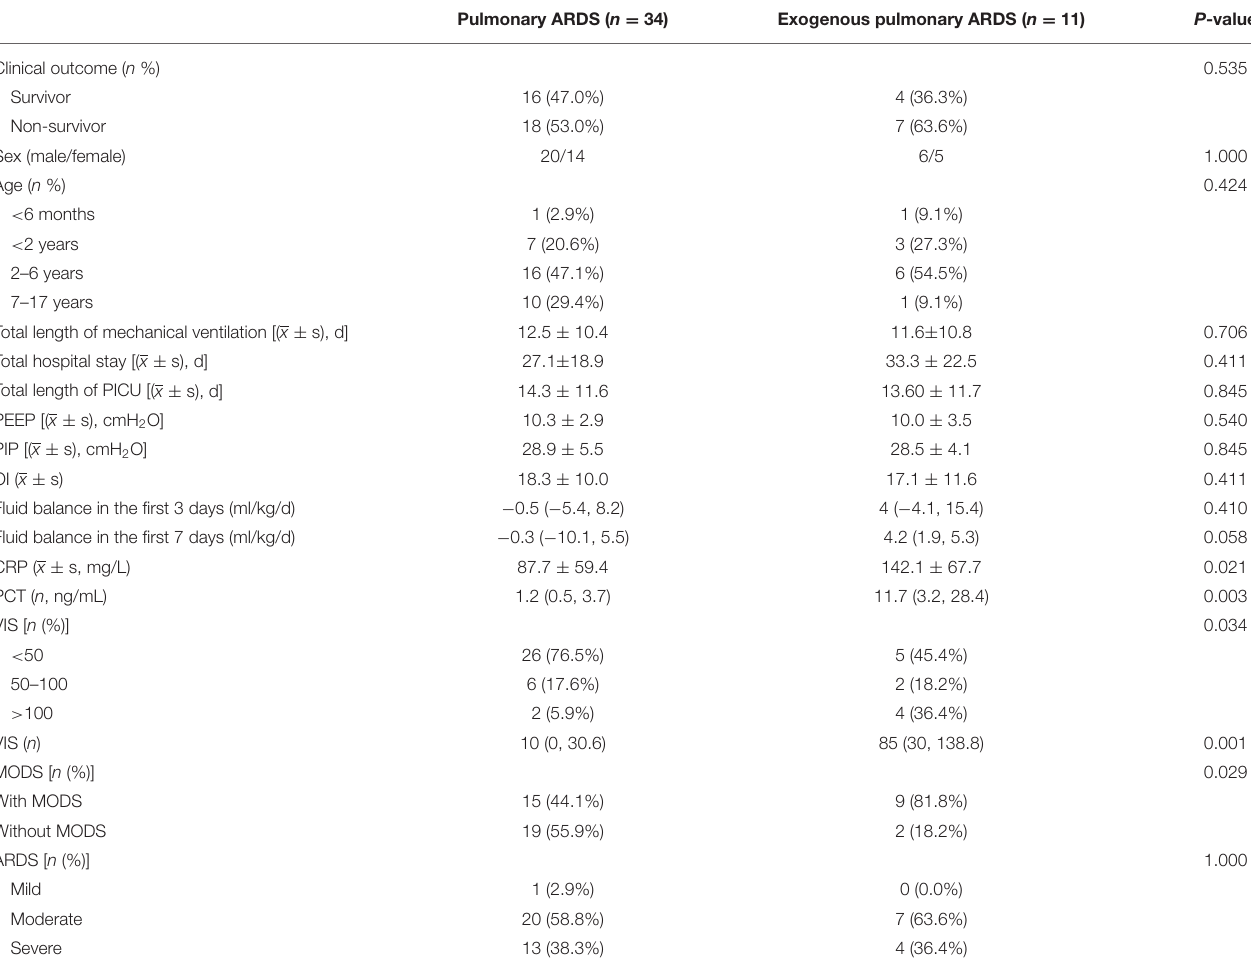
TABLE 3 | The characteristics of ARDS in children with hematologic neoplasms: pulmonary ARDS and exogenous pulmonary